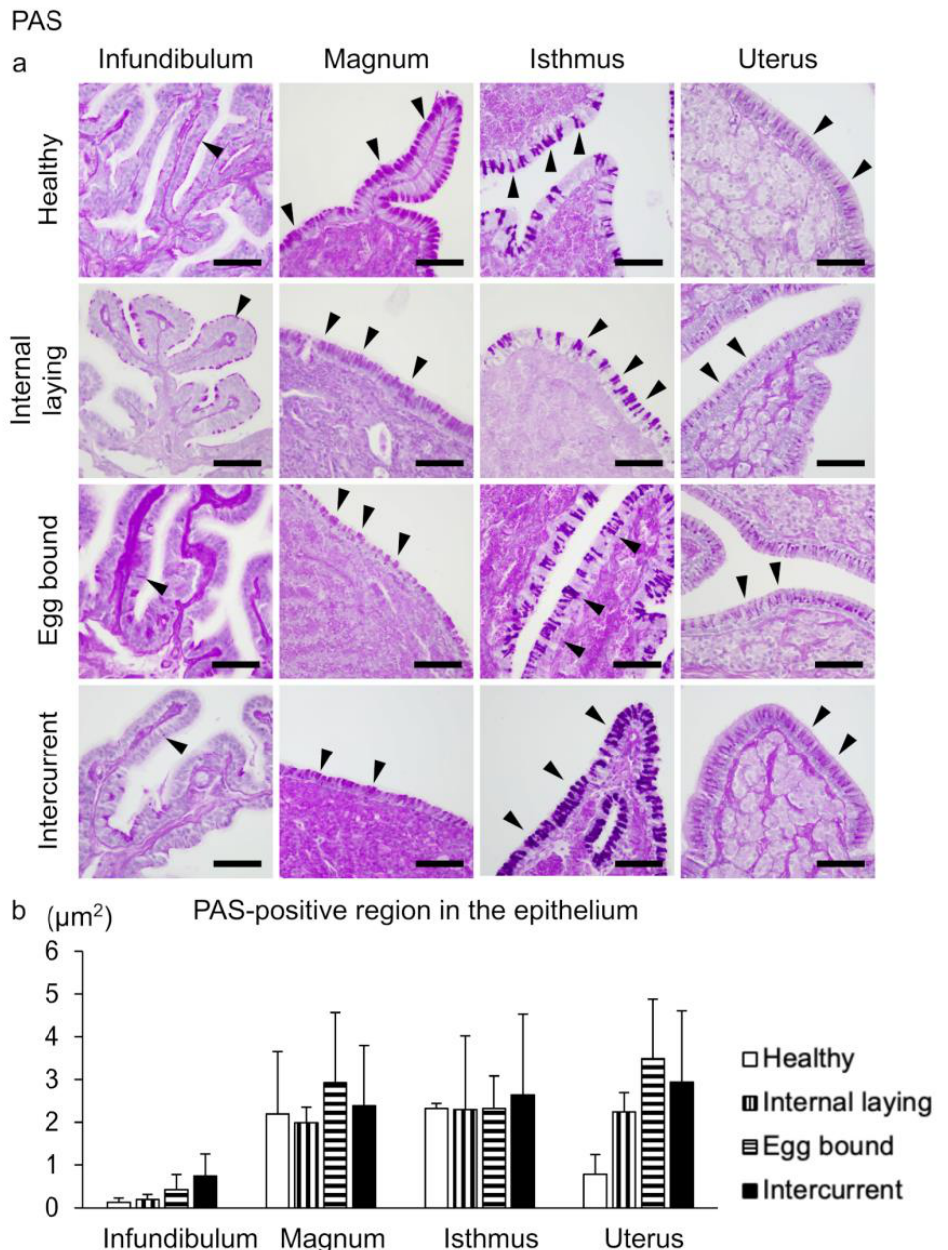
Figure 5. Secretory cells distribution in the oviductal epithelium in laying hens. ( a ) Periodic acid– Schiff stain (PAS) for detecting secretory cells of oviducts. Arrowheads indicate the PAS-positive secretory cells on the epithelium. Bar = 50 µm. ( b ) The percentage of PAS-positive area in the epithelium. There are no significant differences among groups (Tukey–Kramer test, n = 4 for each group). Data are presented as the mean + SE.